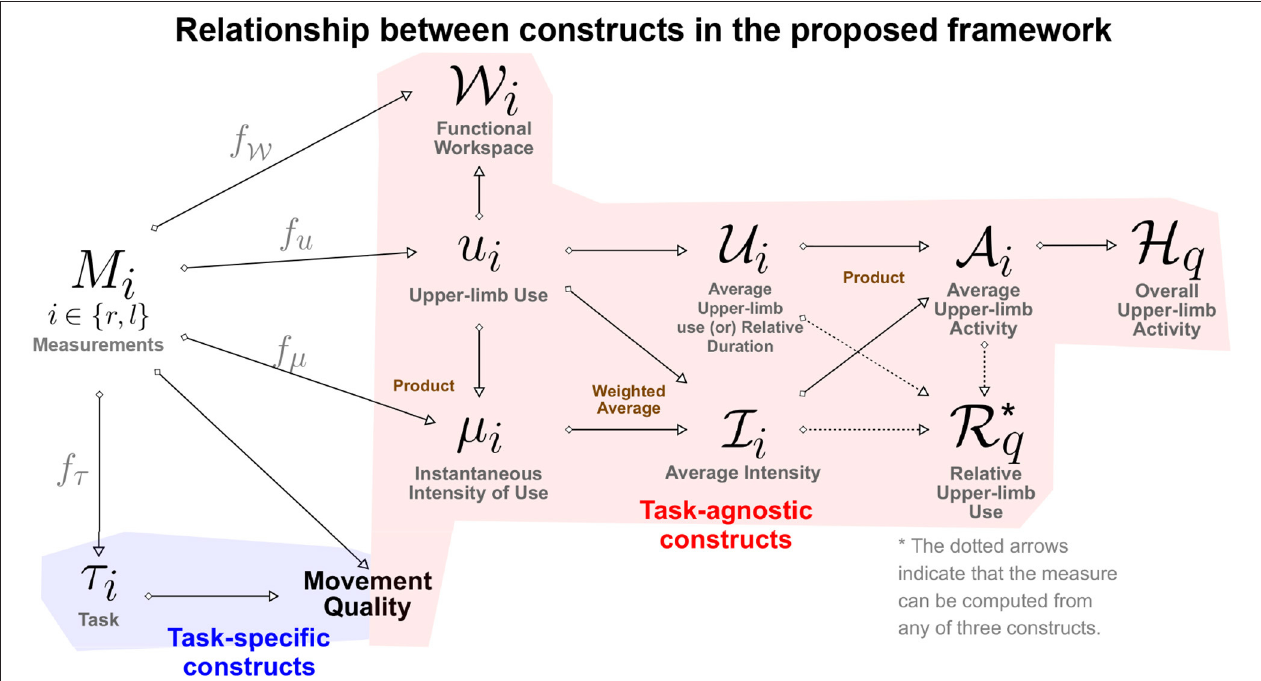
FIGURE 2 | A directed graph representation of the connections between the different constructs defined in the proposed framework. The leftmost node represents the measurements, while the rest of the nodes are constructs of interest in the assessment of upper-limb functioning. The construct at the end of a directed edge is derived using the construct/measurements at the start of the directed edge. The measures (gray color text) used to quantify a construct from measurements are placed above the directed edge. The brown colored text next to some of the construct indicate how two constructs are combined to derive the target